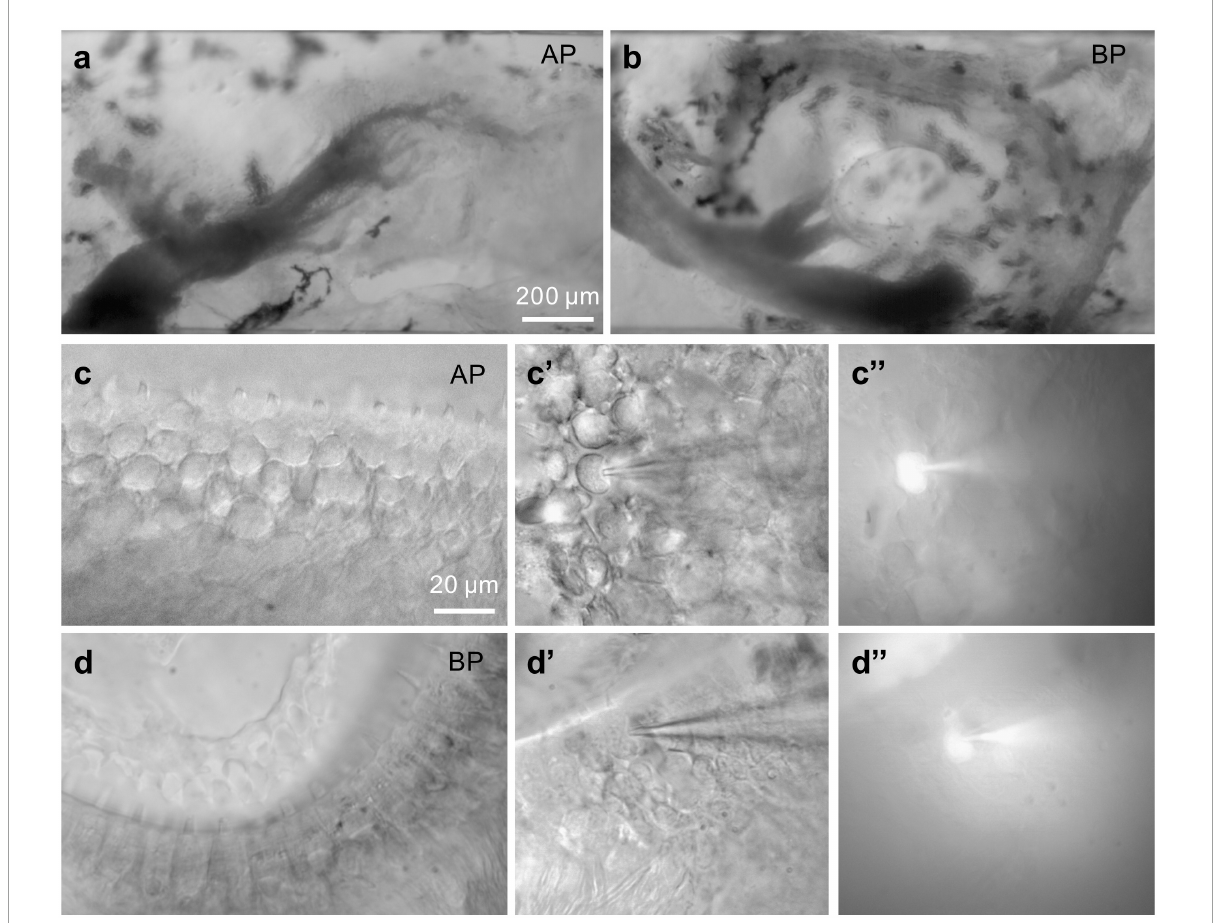
FIGURE1 Images of bullfrog’s AP and BP. (a,b) Shown above are the amphibian papilla (AP) (a) and basilar papilla (BP) (b) preparation under a 10 × microscope, respectively. (a) : In this view of AP, rostral is to the right, caudal to the left. The sensory epithelium is visible and runs horizontally. Recordings were made from hair cells in the mid-regions of the AP, which responds to the sounds at frequencies of approximately 250–750 Hz. The scale bar is approximately 200 µ m. (c,d) Displayed are the higher magnification images of medial AP (c) and BP (d) hair cells under a 60 × microscope. (c’,d’) Bright-field images of hair cells from the medial AP (c’) and BP (d’) under voltage-clamp. A recording pipette filled with Alexa488-internal solution is on the right, approaching and patching the hair cell. Then, hold on for several minutes. The fluorescent cells (c,”d”) are indicative of internal solution influx, successfully patching the given cells (bars: 20 µ